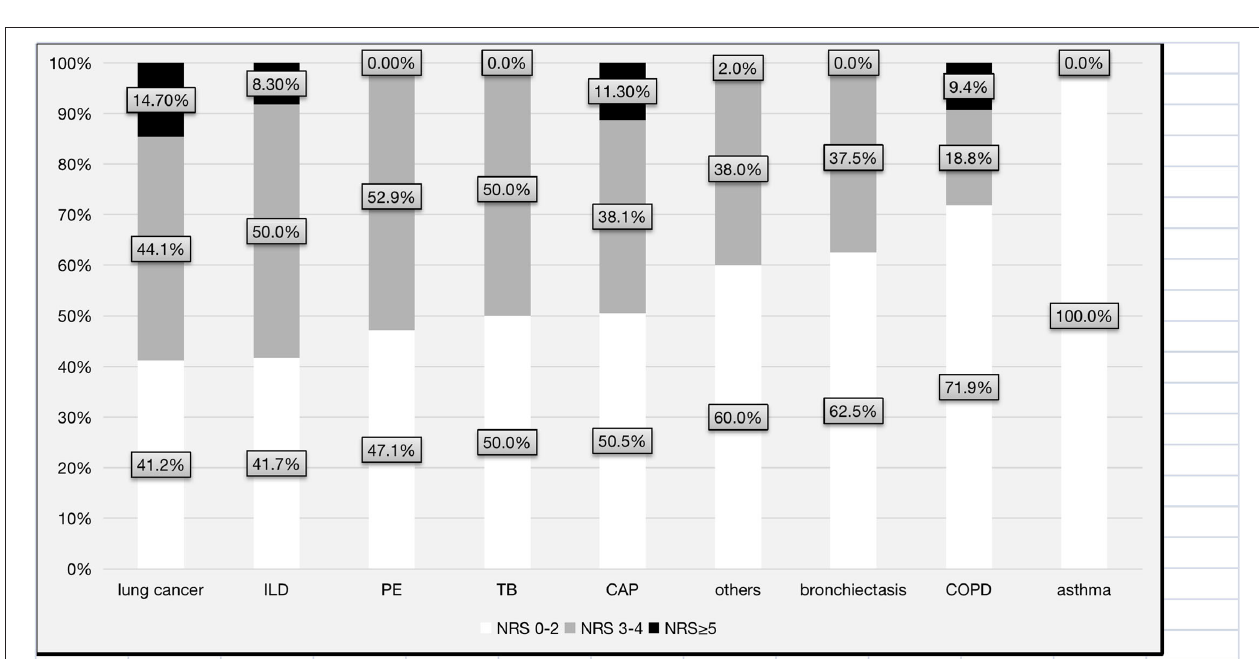
FIGURE 2 | Distribution of the levels of nutritional risk for each major respiratory diagnosis. CAP, community-acquired pneumonia; COPD, chronic obstructive pulmonary disease; TB, tuberculosis or tuberculous pleurisy; PE, pulmonary embolism; ILD, interstitial lung disease; NRS-2002, Nutrition Risk Screening 2002.